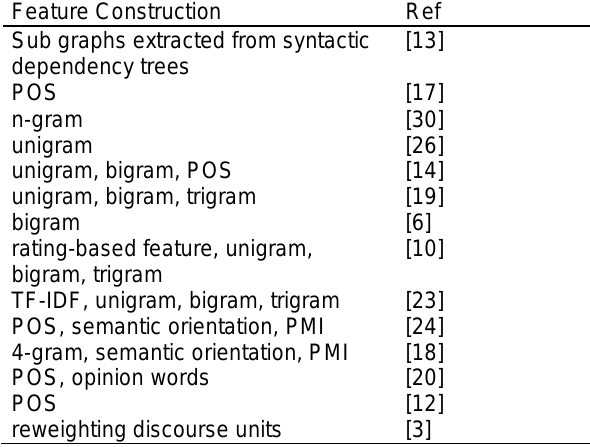
From Table 4, the features most used are: Unigram, bigram, POS, semantic orientation and PMI.